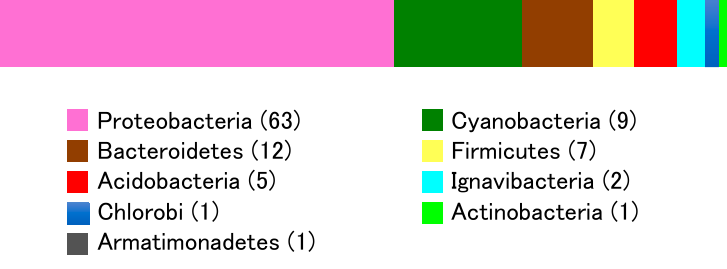
Figure 2. Community structure of bacterial clones at the phyla level. The number in parenthesis is the number of operational taxonomic units (OTUs) belonging to each phylum. Table 1. List of bacterial clones.